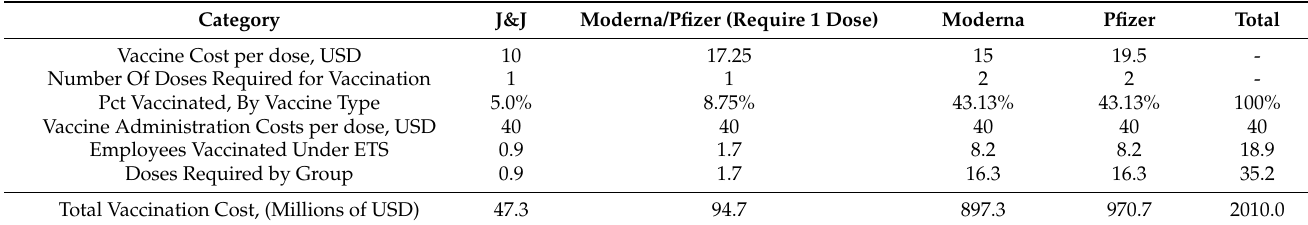
Table 5. OSHA’s COVID-19 Vaccination and Testing ETS, Vaccine Costs.